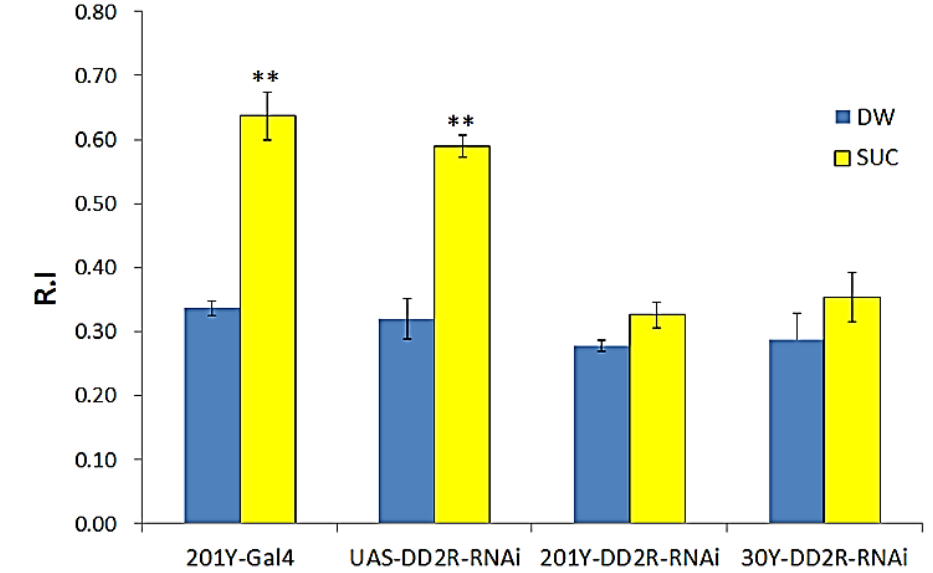
Figure 5. Expression of DD2R-RNAi in the mushroom body-impaired appetitive olfactory learning in Drosophila larvae. 201Y-Gal4 and UAS-DD2R-RNAi lines were used as controls for this experiment. Number (n) of separate experiments: 201Y-Gal4 with water (DW) or QH (3), UAS-DD2R-RNAi with DW or QH (3), 201Y-Gal4 × UAS-DD2R-RNAi (201Y-DD2R-RNAi) with DW or with QH (5), and 30Y-Gal4 × UAS-DD2R-RNAi (30Y-DD2R-RNAi) with DW or with QH (6). Student t-test, ** p <